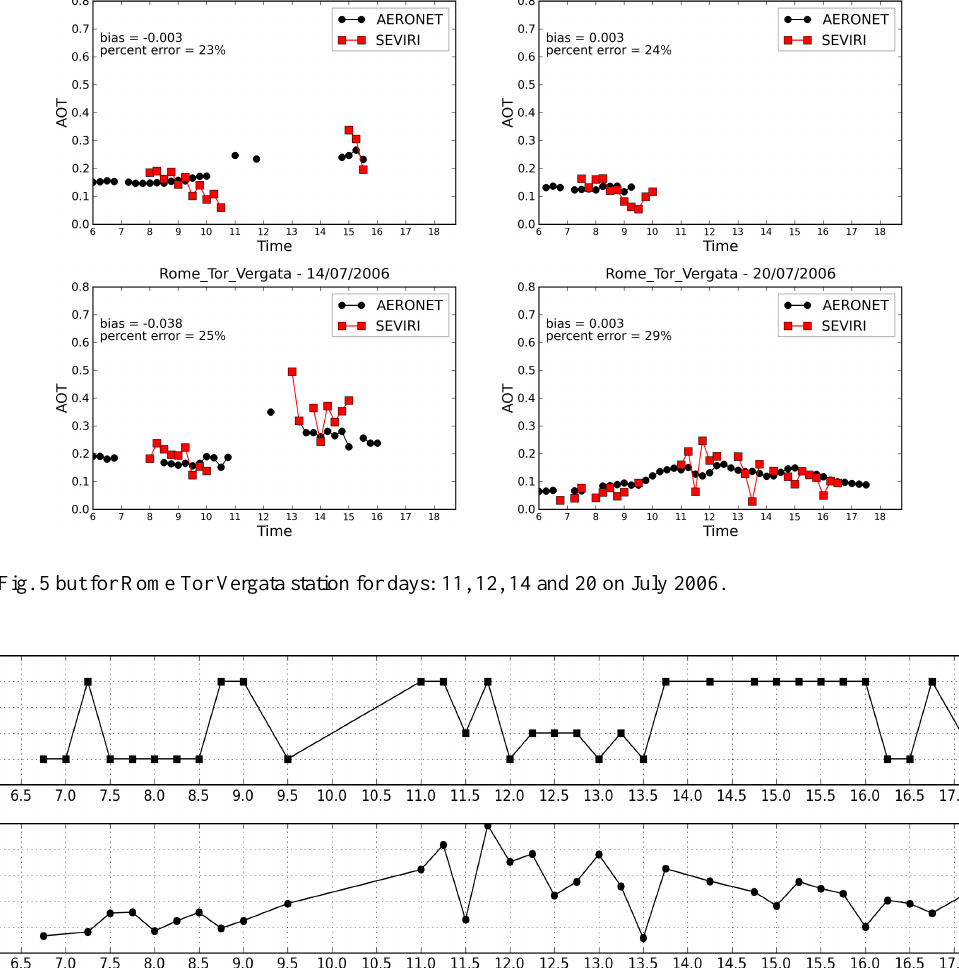
Fig. 5. Temporal evolution of the aerosol optical thickness above Cabauw for some days in July 2006: from 1 to 4 and on 13 and 25. The black line is AERONET and the red line is SEVIRI. The time scale is from 6:00 to 18:00 UTC and the AOT scale is from 0 to 0.7. The mean bias and the mean relative bias are indicated on each plot.